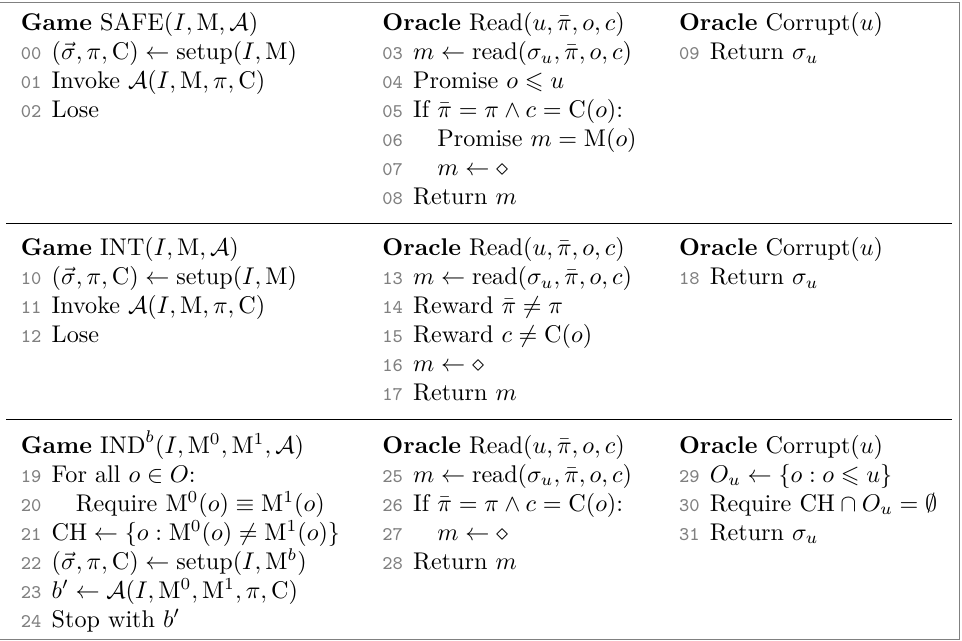
Figure 4: Games for ROES. For all values u, ¯ π, o, c provided by the adversary we require that u ∈ U , ¯ π ∈ Π, o ∈ O , c ∈ C . Read CH like in challenge. Assuming (cid:5) / ∈ M , we